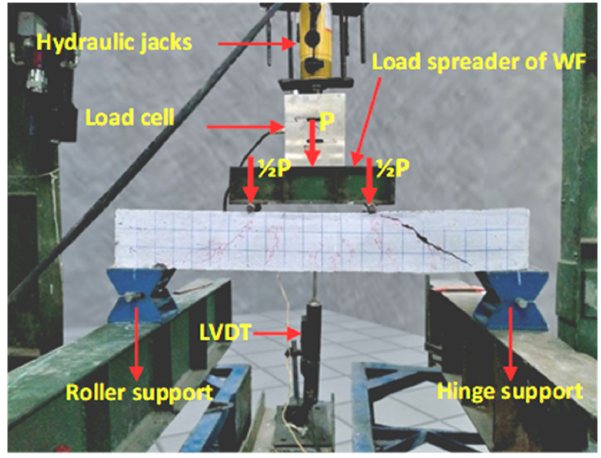
Figure 4. Test arrangement of bamboo-reinforced concrete beams.